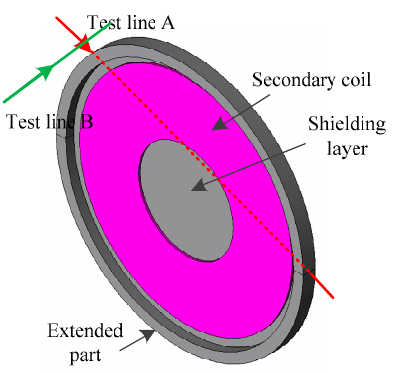
Figure 24. Secondary side of the finite element analysis model.